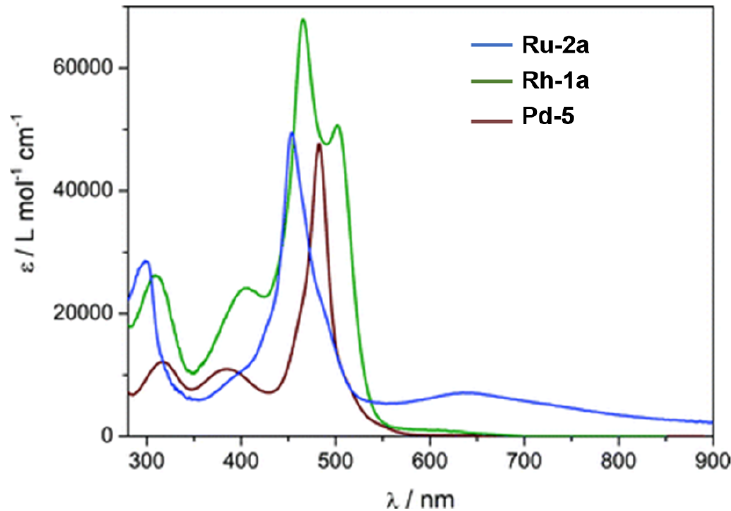
Figure 13. Visible absorption spectra of these complexes in DMSO. Exciton coupling is visible in the absorption spectra of Rh-1a . Reproduced with permission from [67]. Copyright © 2010 Royal Society of Chemistry.